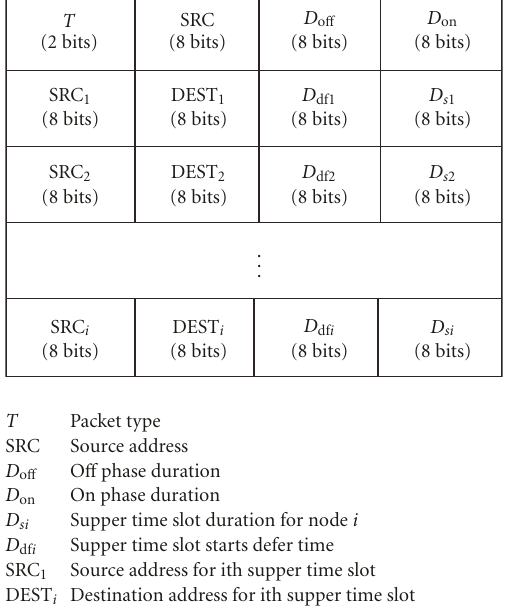
Figure 4: Schedule message packet format for ASMAC.